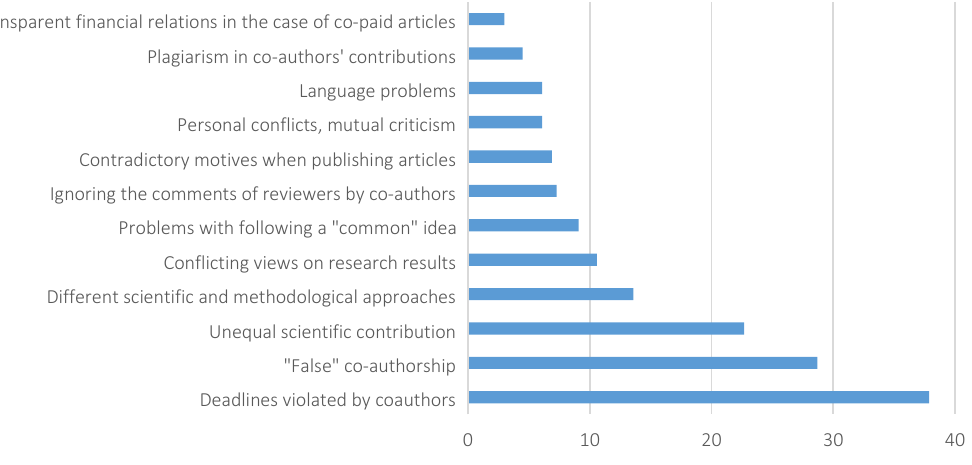
Figure 7. Conflicts or other issues related to co-authored publishing